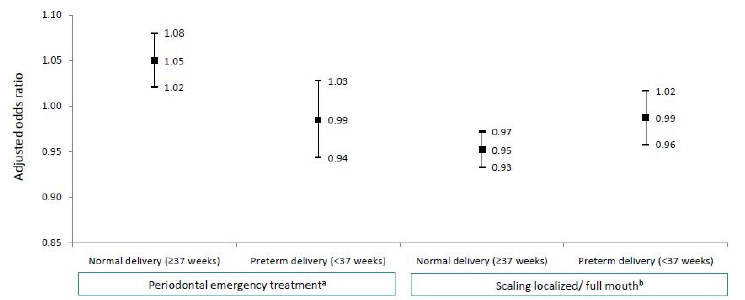
Figure 2. Multivariable logistic regression analysis of factors associated with low birth weight. The vertical lines represented the range of adjusted OR of each risk factors. a Mothers who have had periodontal emergency treatment within 2 years before pregnancy; b Mothers who have had localized scaling within 2 years before pregnancy.